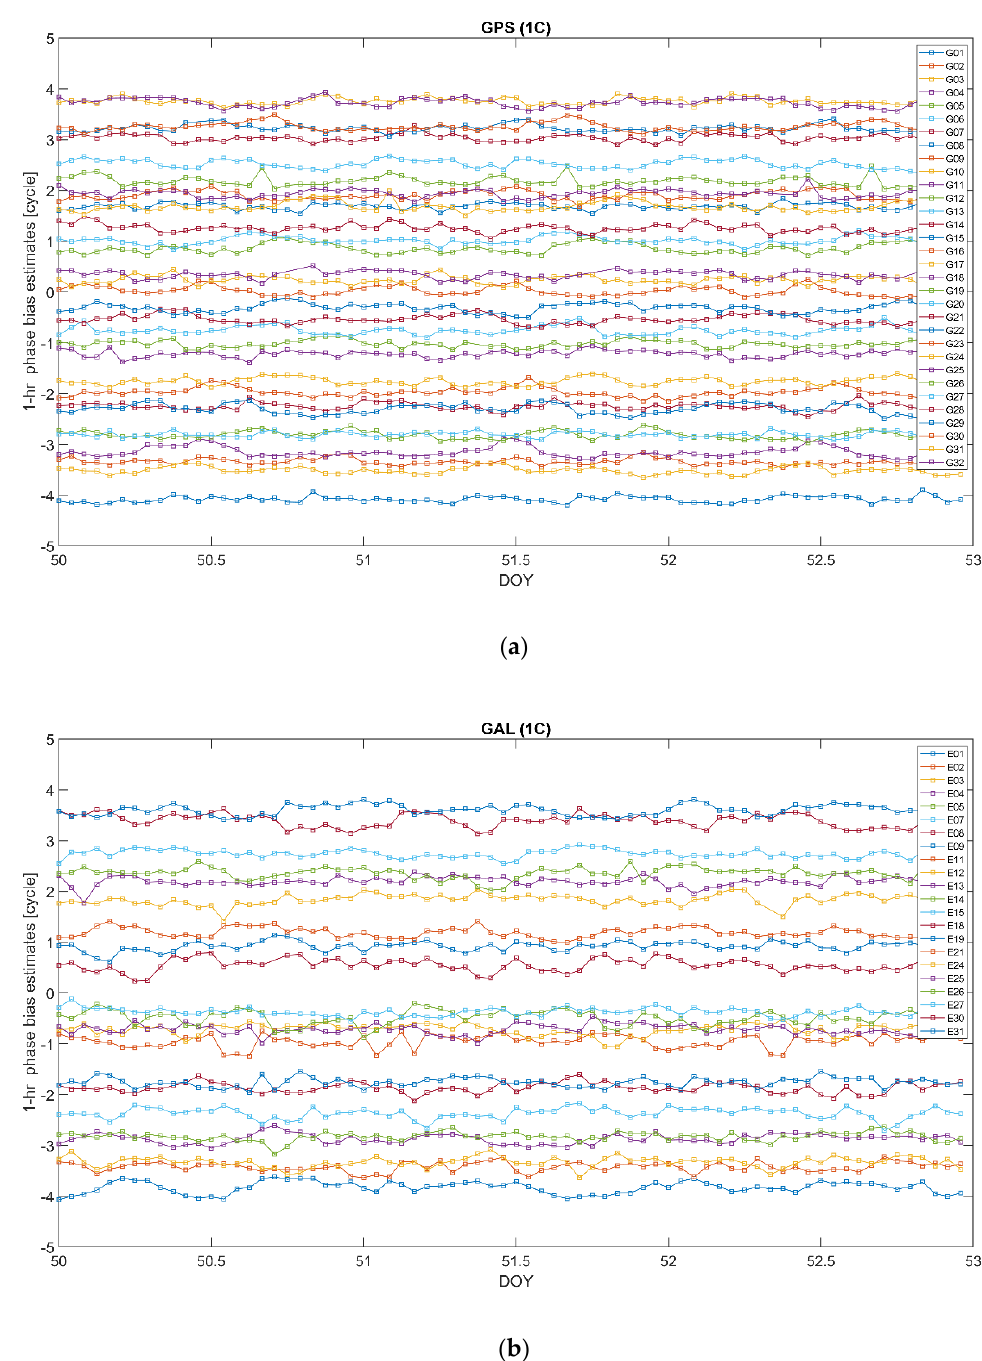
Figure 10. Sub − daily (hourly) bias ϐ MWCs estimates over a 3 − day time interval 2020/50 – 2020/52 for GPS L1 ( a ) and GALILEO E1 ( b ). The time series for individual satellites are shifted along the y-axis by PRN −16 times 0.25. “1C” corresponds to L1 C/A for GPS and E1 pilot channel for GALILEO. We then compare distributions of the residuals of the sub-daily (1 h and 3 h long) s , in order to find out which bias update time step may be more optimal. estimates of ϐ MWC The distributions are demonstrated in Figure 11.